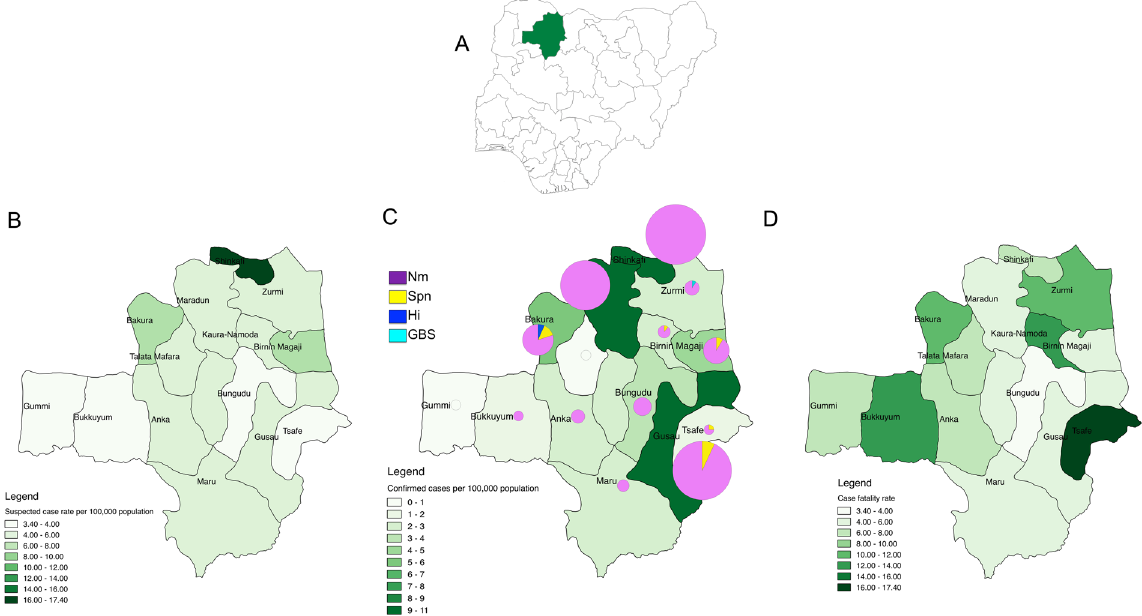
Figure 2. The geographical distribution of the meningitis outbreak in Zamfara State. The location of Zamfara state in Nigeria is shown in ( A ). Suspected cases per 100,000 population ( B ), laboratory-confirmed cases per 100,000 population ( C ) and case fatality rates ( D ) across LGAs are shown by colour gradient. The pie charts represent the pathogens detected in confirmed cases ( C ).